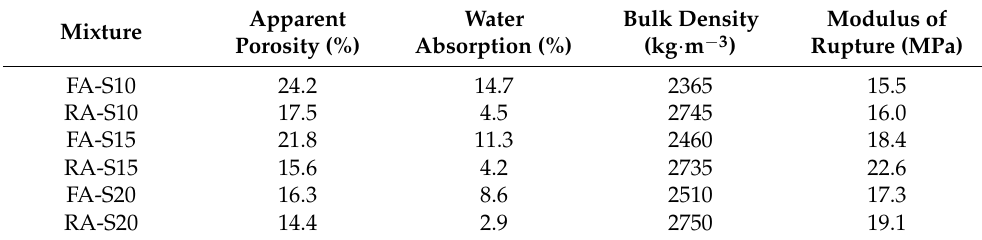
Table 4. Results of experiments to determine physico-mechanical properties.